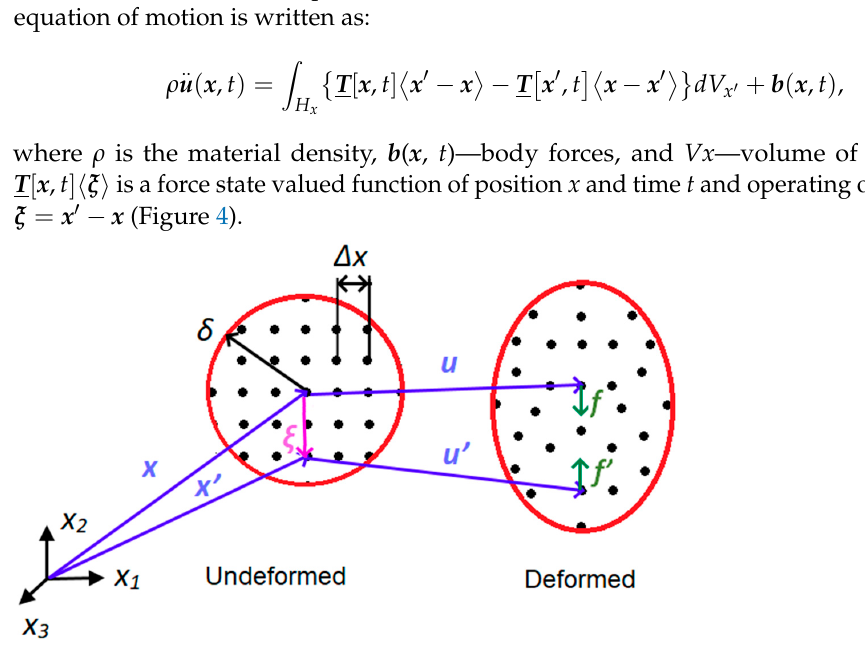
Figure 4. The basic principles of the PD theory.